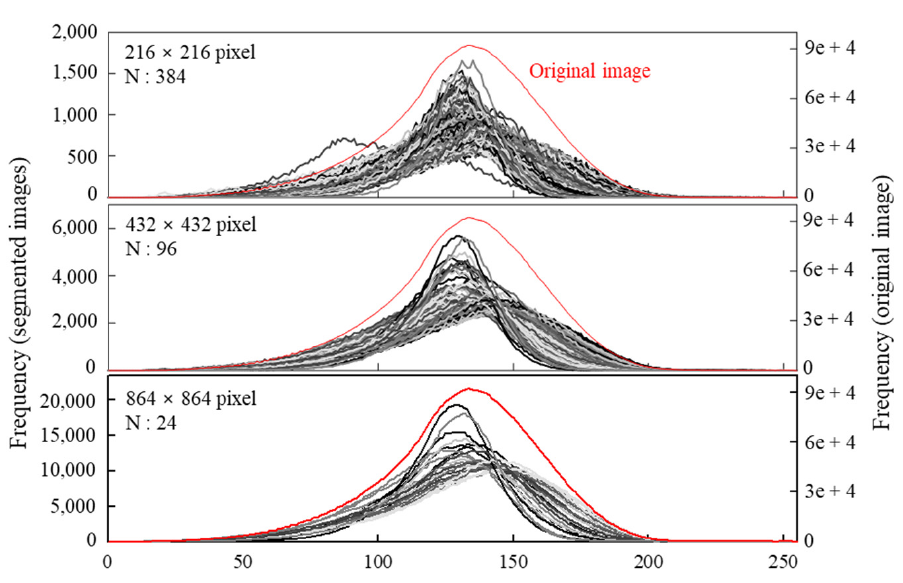
Figure 7. Gray value histogram of soil surface images. The solid red line is a histogram of the original soil surface image, and the solid grayscale lines are histograms of segmented images. N is the number of segmented images and its histograms.